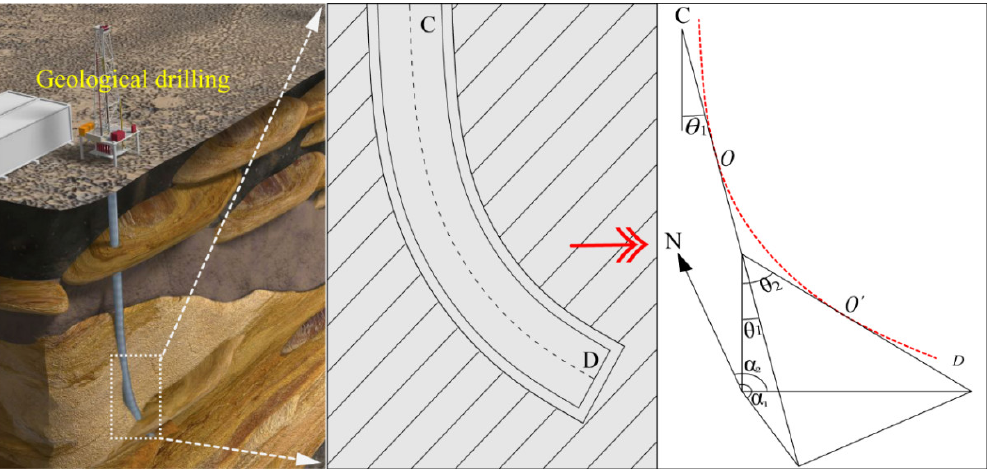
Figure 1. Schematic diagram of drilling-core spatial geometry model ( θ 1 : apex angle of point O; θ 2 : apex angle of point O′; α 1 : azimuth angle of point O; α 2 : azimuth angle of point O′).